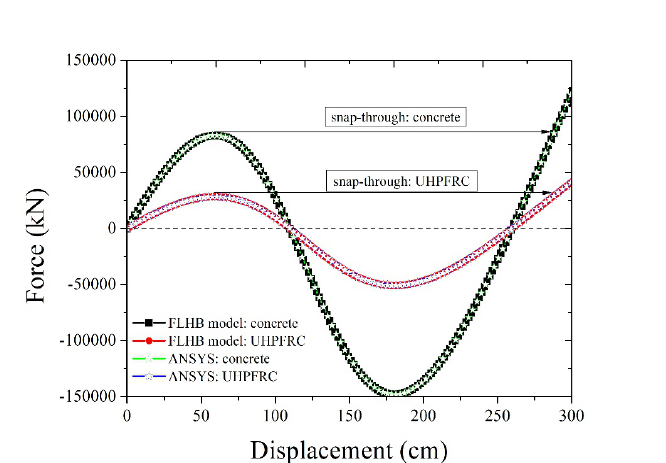
Figure 4. Vertical displacement vs . force for node 8, linear material